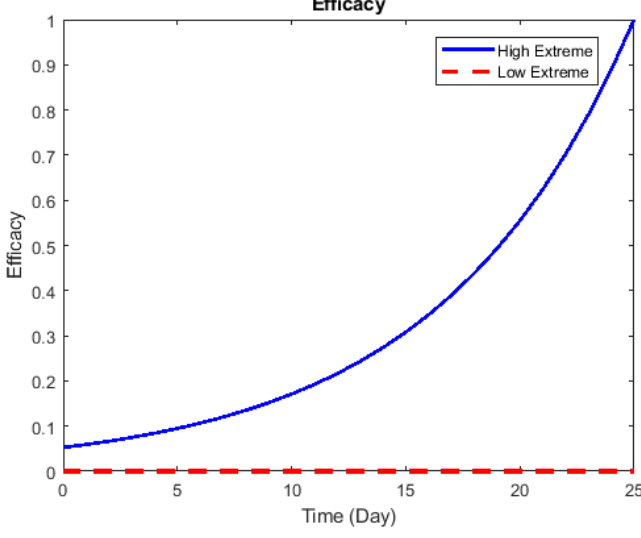
Figure 4. Extreme cases validation.